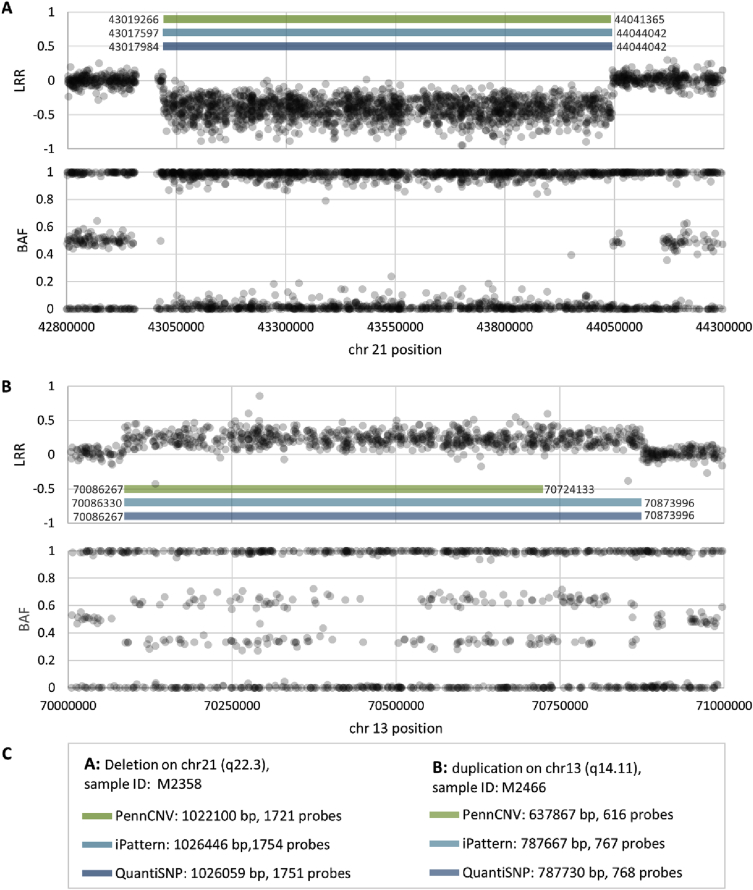
Examples of CNV deletion and duplication detected by all three algorithms. CNV length and number of probes for each algorithm were provided. Start and end probe positions for each algorithm were presented on the corresponding bars. Outer start and end positions were used as start and end positions of the stringent CNV. A: An example of deletion found in chr21q22.3; B: An example of duplication found in chr13q14.11; C: the start and end positions of the CNV detected by each of the algorithms and corresponding number of probes. LRR: Log R ratio; BAF: B allele frequency.